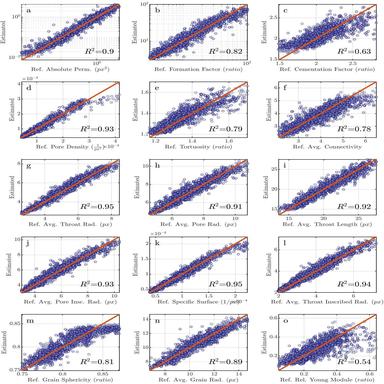
Comparison between the reference and estimated values for 15 single–value features and their correlation coefficients, a to o charts correspond to the features inscribed in 1 rows from 1 to 15.